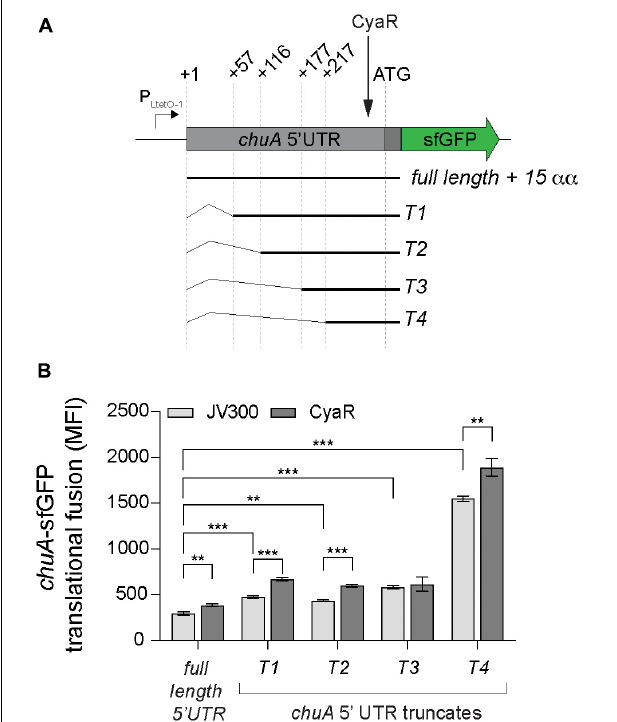
FIGURE 4 | The chuA 5 (cid:48) UTR contains a sequence that disrupts its translation independently of CyaR. (A) Diagram indicating the positions of the different chuA- sfGFP truncates used. (B) Fluorescence measurements of full-length and truncated chuA- sfGFP constructs in the presence and absence of CyaR overexpression plasmid. The position of the CyaR binding site is indicated. Measurements are the mean median fluorescence intensity of three biological replicates (*** p < 0.001, ** p <